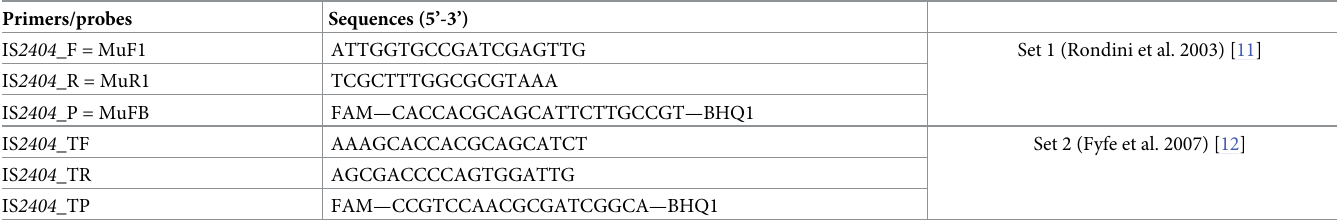
Table 1. Sequences of primers and probes used during the SOP harmonization procedure.